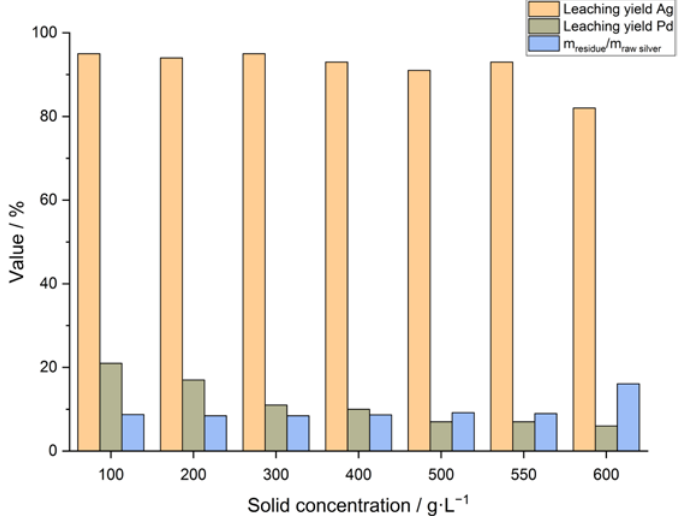
Figure 2. Summary of the leaching results for different solid concentrations.